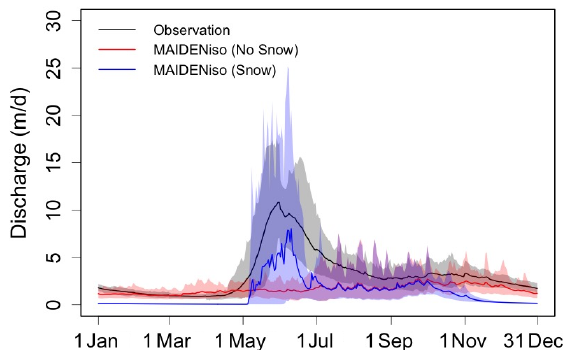
Figure 4. Water outflux (drainage + runoff) simulated for 1979– 1997 in the Caniapiscau site by MAIDENiso (smoothed over a 10d period), without (red) and with (blue) the snow module. The black line shows the discharge from observations from the Caniapiscau basin between 1979–1997, scaled with the area of the basin. Solid lines indicate the average of the same DOY during this period, and shadows indicate the 2 σ